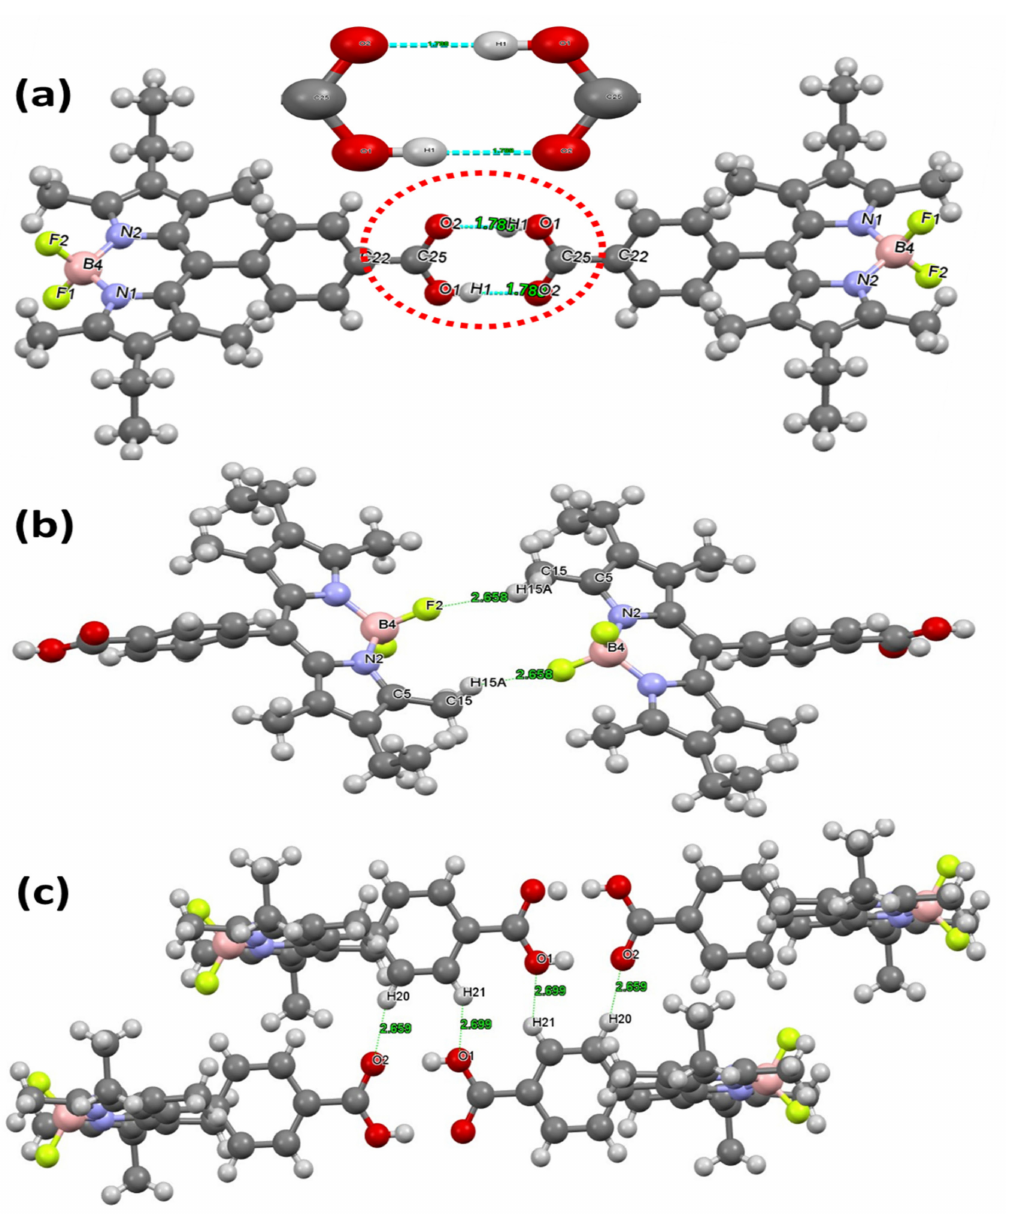
Figure 4. ( a ) O-H . . . .O, ( b ) C Me -H . . . ..F, and ( c ) C ring H . . . .O H-bonds